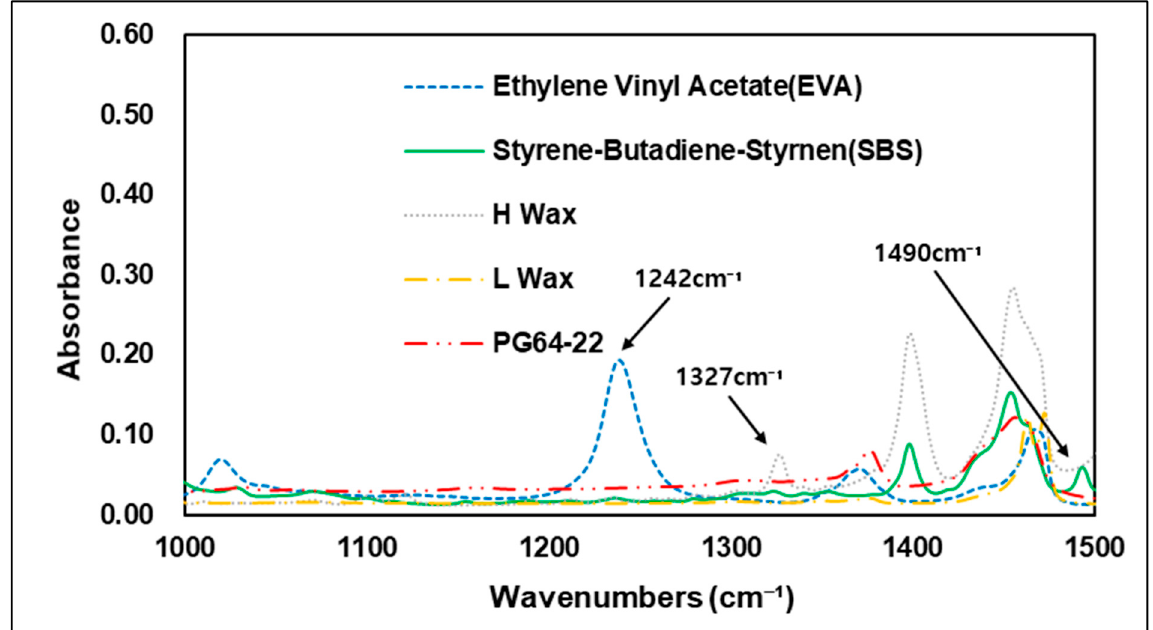
Figure 6. FTIR Spectrum of 1000–1500 cm − ¹ area. Table 2. Particular wavenumbers of each additive.